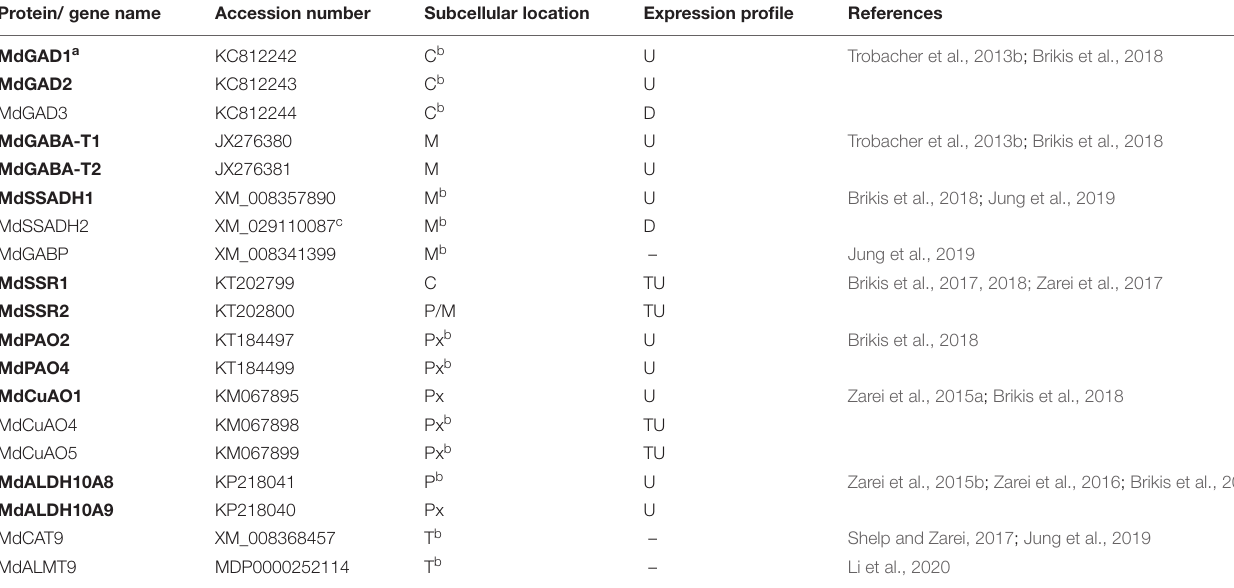
TABLE 2 | Key proteins/genes of GABA metabolism and signaling in apple fruits subjected to low temperature, controlled atmosphere